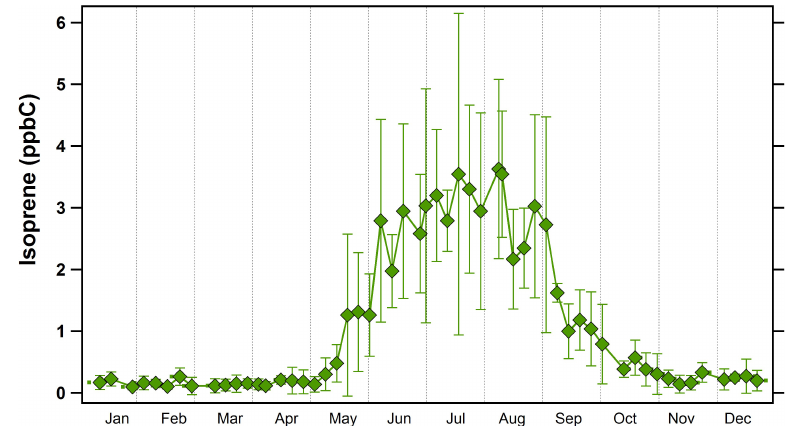
Figure 2. Annual climatology of isoprene concentrations in Essex, Maryland (2011 to 2015). Symbols represent average concentrations (in ppbC or nmolCmol − 1 ) while error bars represent ± 1 σ